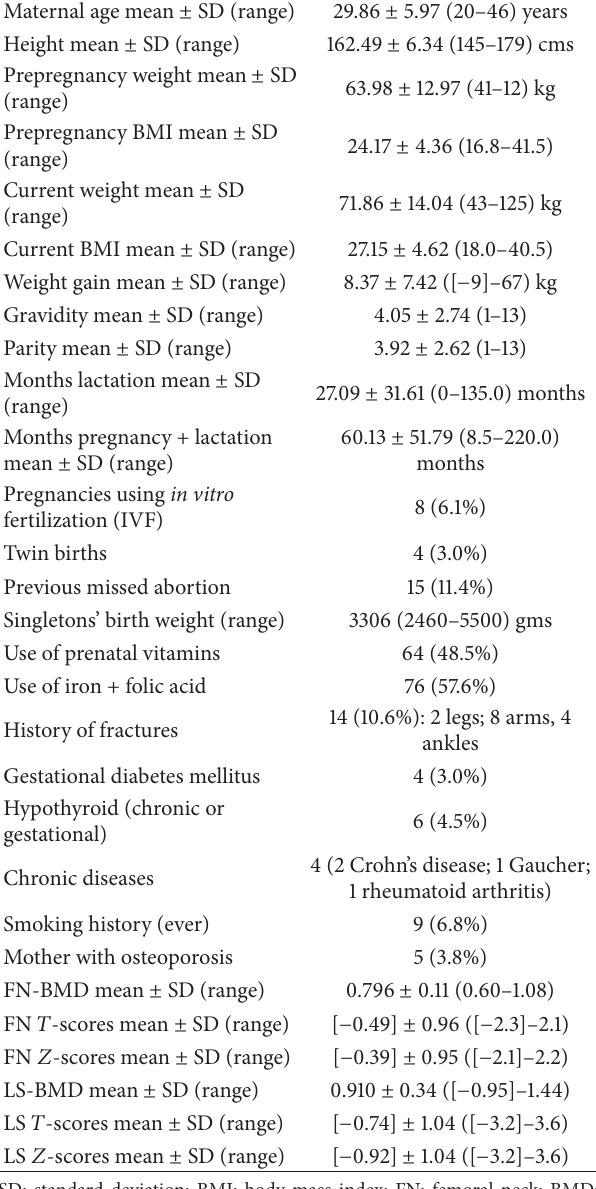
Table 1: Demographic data of the cohort ( 𝑛 =